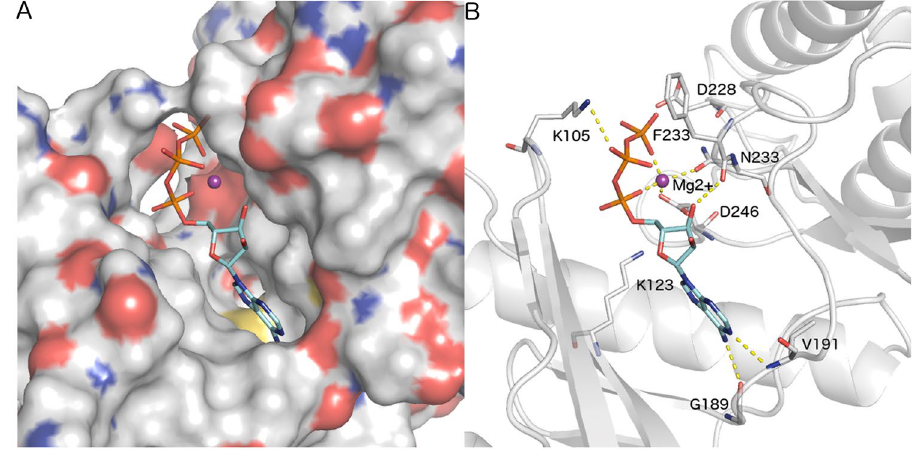
Figure 4. Surface structure of the Ss -RIOK-2 ATP binding pocket and interaction of ATP within modeled structure of Ss- RIOK-2-ATP. ( A ) Surface structure of the ATP binding pocket of Ss- RIOK-2-ATP. Blue is positive, red is negative, Mg 2 + is shown as a purple sphere, ATP and catalytic residues are shown in stick representation. ( B ) Interaction of ATP with key residues present within the binding pocket of Ss- RIOK-2-ATP.